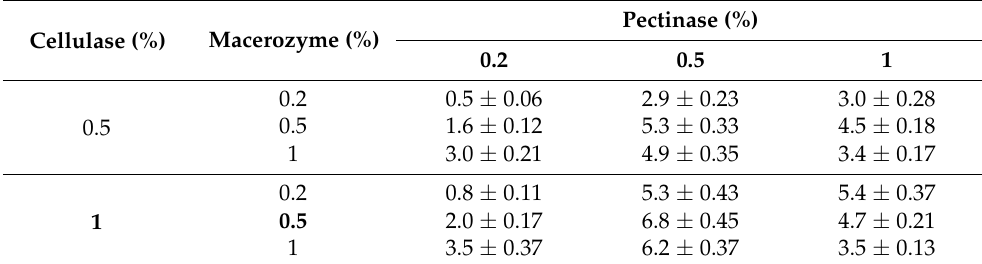
The optimal enzyme combinations are highlighted by bold letters. The numbers indicate the average protoplast yield ( × 10 5 cell/gFW) from three replicates with the standard error shown in the table. The enzymatic digestion buffers contain chloride and sodium, which will inevitably stress the cell and generate global transcriptional inductions for genes involved in stress responses and turgor maintenance [38]. It should be noted that the effect of protoplasting on the transcriptome must be filtered out from the scRNA-seq data by a sister RNA-seq experiment, comparing the isolated protoplasts and the undigested tissues [13,17]. How- ever, cautions should be taken for developmental genes, whose expression is dynamically regulated by conditional epigenetic modifications [39–41]. In order to evaluate if the proto- plast production process results in a global epigenome alternation, we monitored the RNA